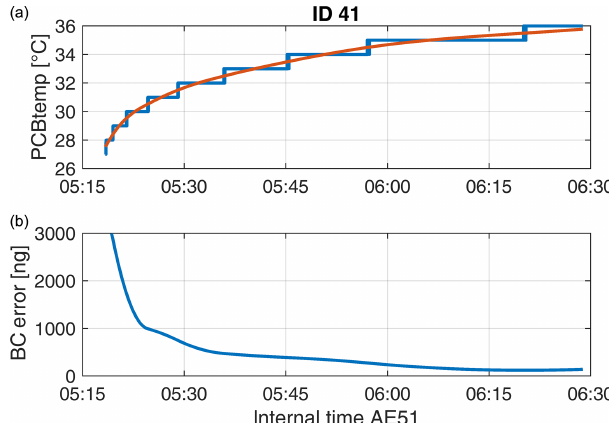
Figure 2. The figure shows the internal temperature (PCBtemp) of the aethalometer AE51 during the measurement flight from 05:16 until 06:30UTC on 14 July 2016 (a) . The bit noise was smoothed for the time interval (red line). Panel (b) represents the calculated error of the black carbon mass concentration.